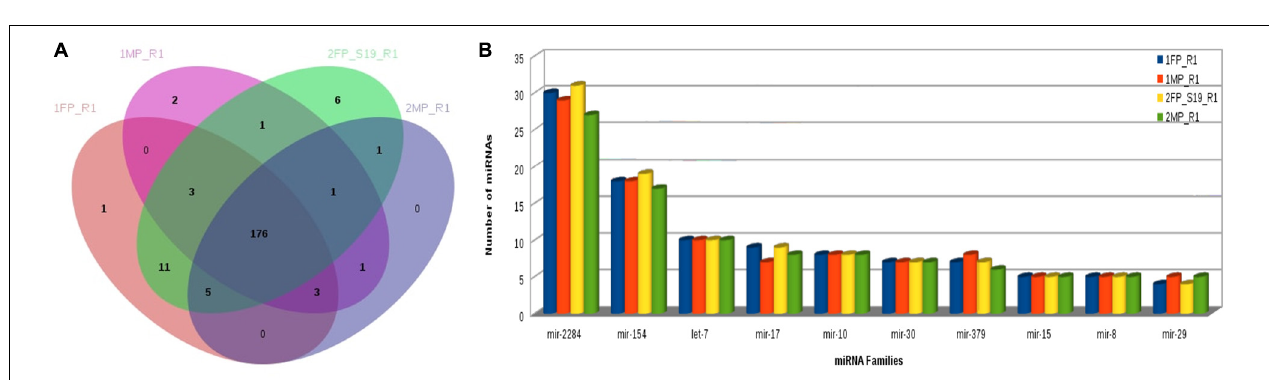
FIGURE 9 | (A) Common miRNA families among all samples. (B) MiRNA family distribution across the